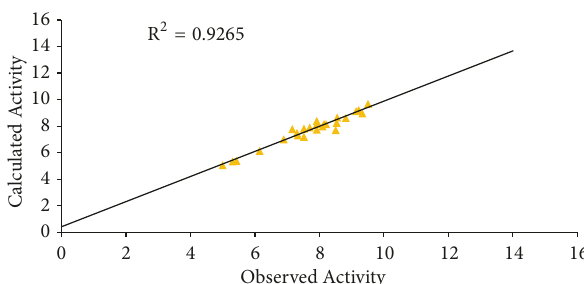
Figure 1: Plot of calculated activity against observed activity of training set.